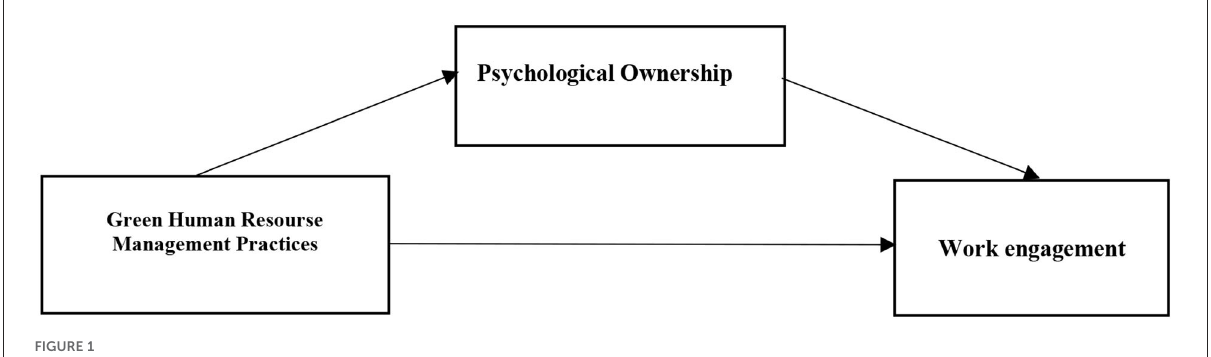
FIGURE1 The research